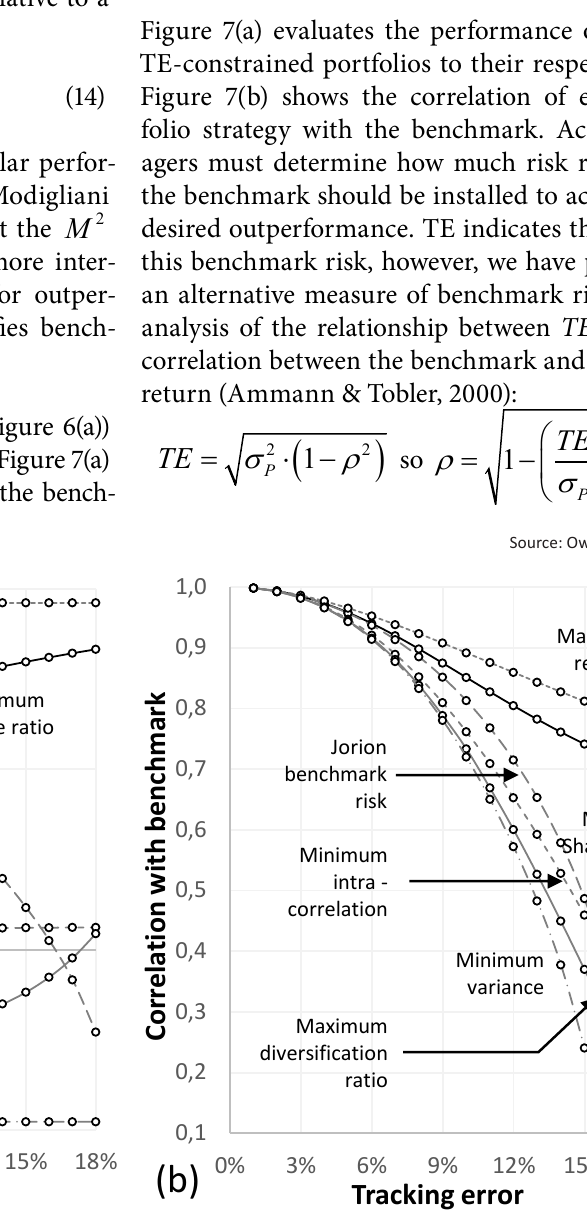
Figure 7. (a) Performance of the six portfolio strategies with respect to their IRs and (b) correlation of benchmark and each strategy’s returns, as a function of TE